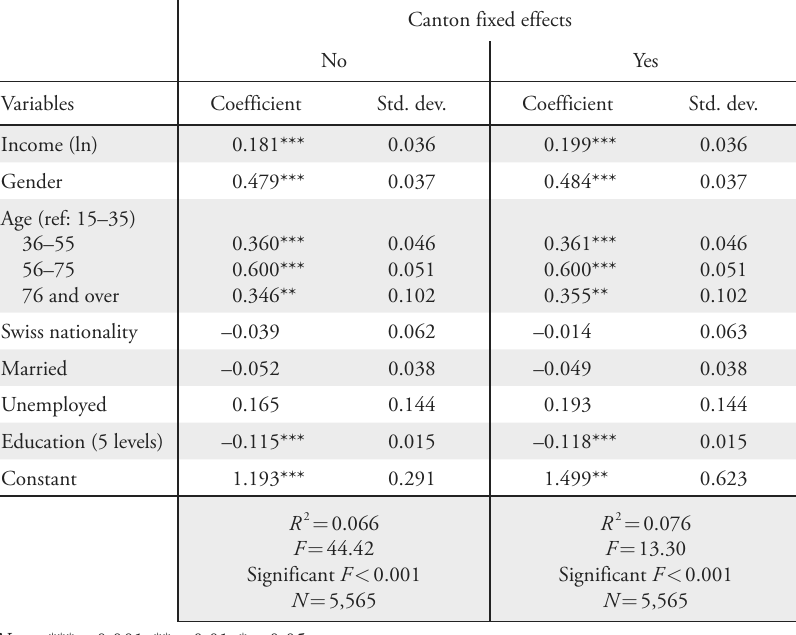
Table 3: Result of the Ordinary Least Squares Regressions Canton fixed